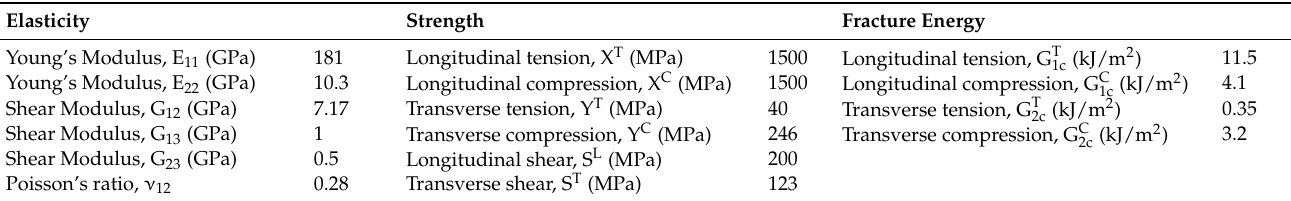
Table 1. Mechanical properties of the unidirectional